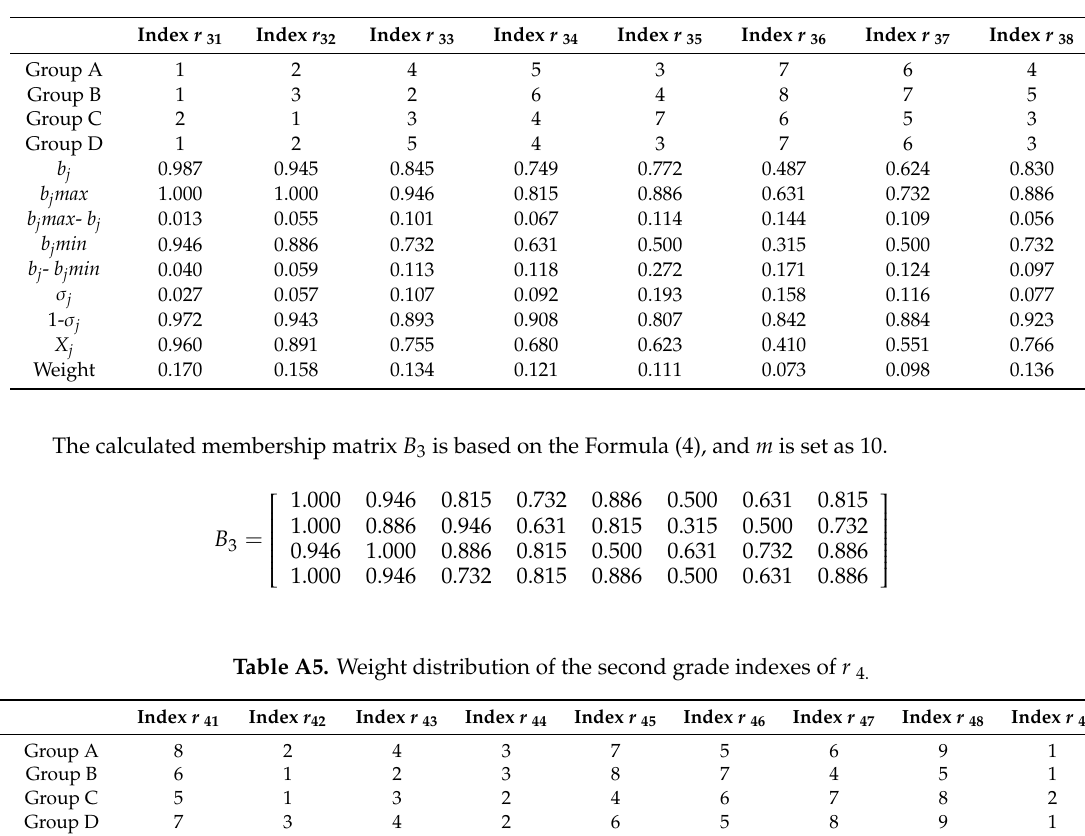
Table A4. Weight distribution of the second grade indexes of r 3.